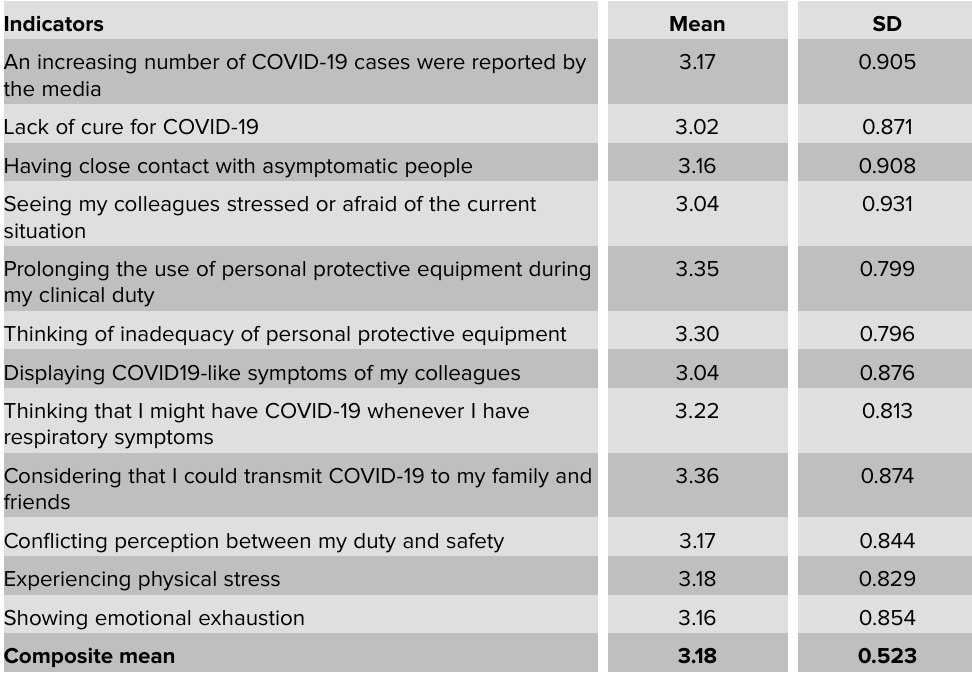
TABLE 2: Factors causing